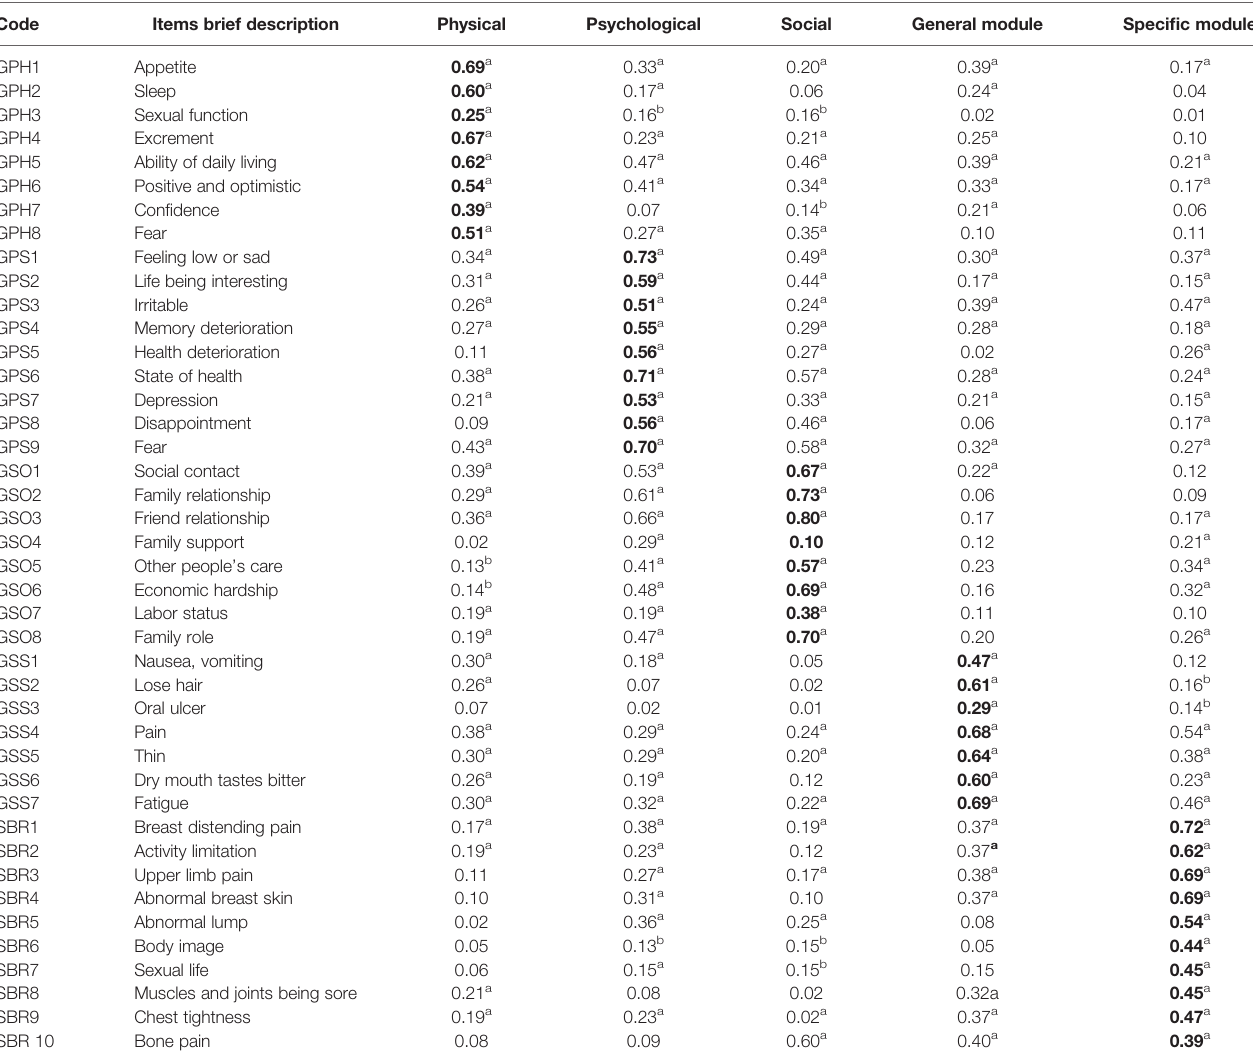
TABLE 2 | Correlation coef fi cient r among items and domains of QLICP-BR (V2.0) ( n = 246). Code Items brief